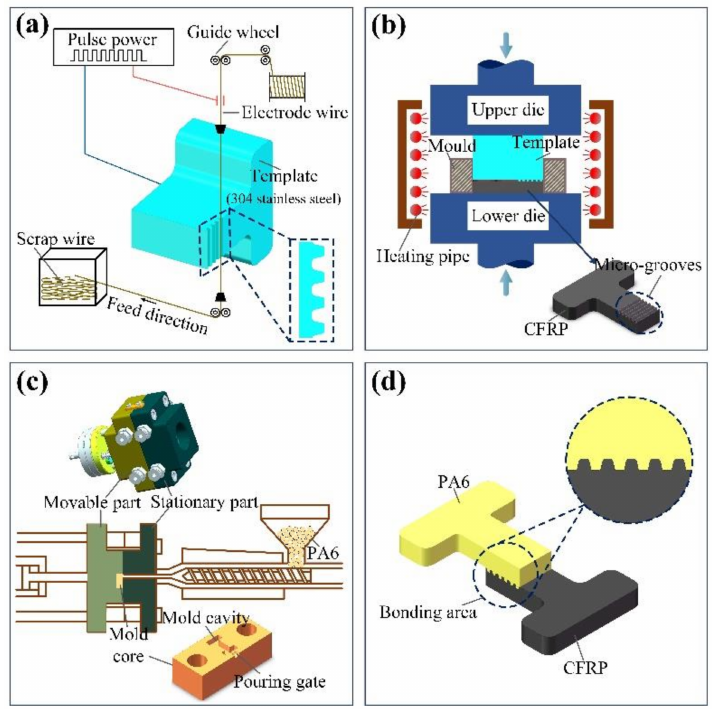
Figure 1. The process flow of composite part preparation: ( a ) fabrication of micro-groove using LS-WEDM; ( b ) compression molding; ( c ) injection molding; ( d ) composite part.